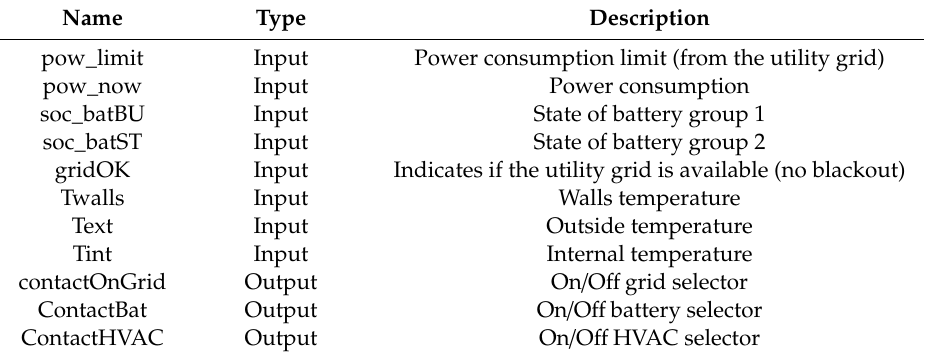
Table 1. Control block inputs /